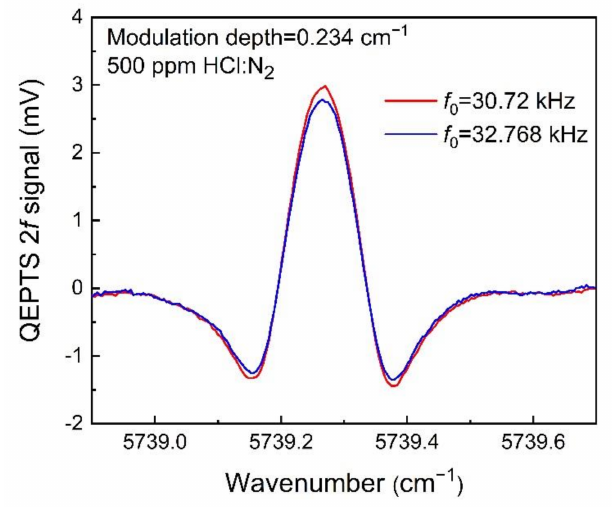
Figure 4. The QEPTS 2 f signals for the two QTFs. The resonance frequencies of the two QTFs are 30.72 and 32.768 kHz (in vacuum), respectively.